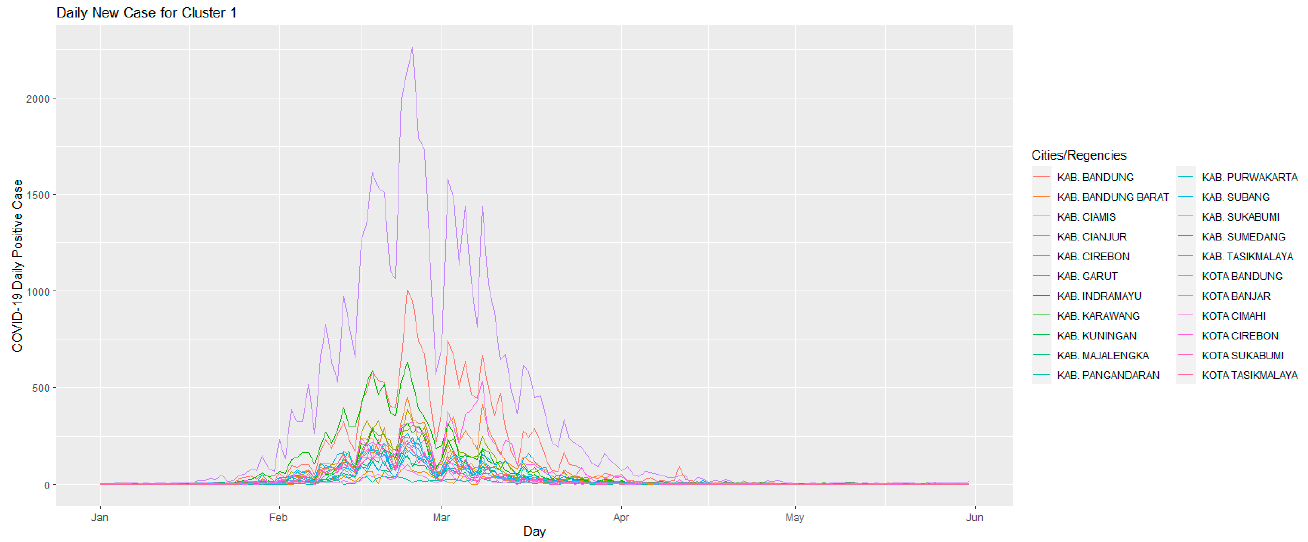
Figure 8. Daily positive cases of COVID-19 in Cluster 1 for the second